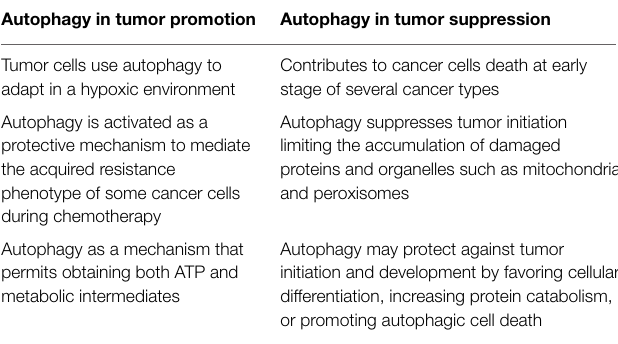
TABLE 1 | Functions of autophagy in cancer